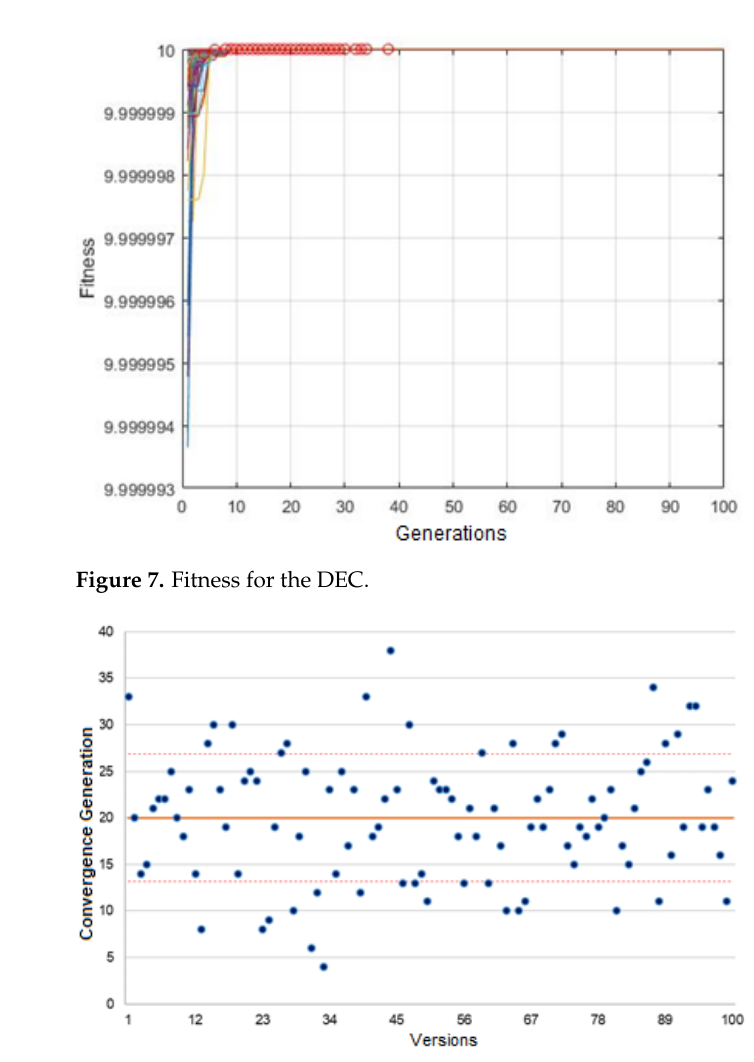
Figure 7. Fitness for the DEC.